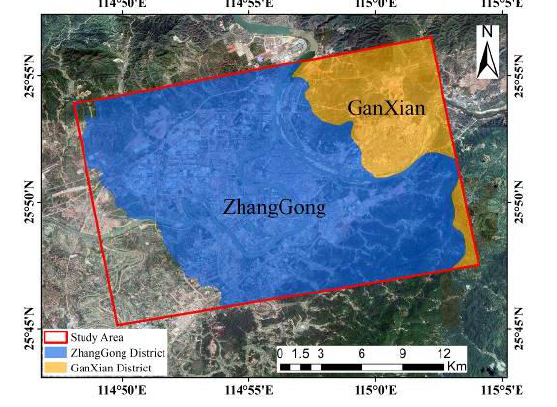
Figure 1. Geographical scope of the study